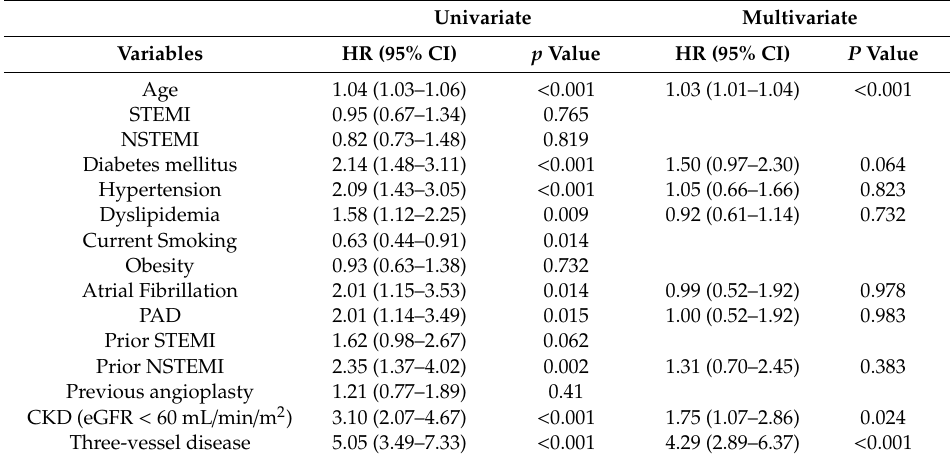
Table 6. Univariate and multivariate analysis of risk factors associated with rSS > 8. Univariate